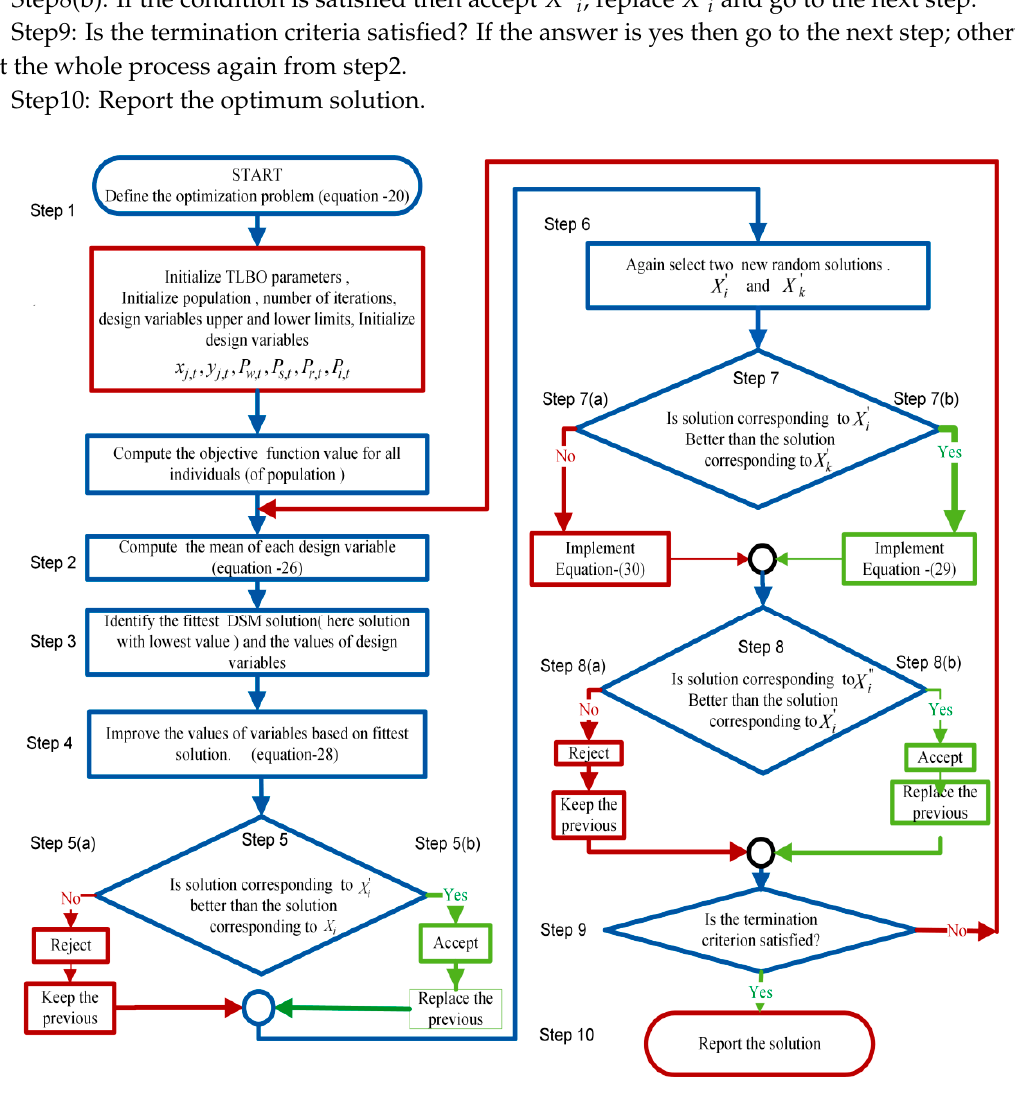
Figure 7. Flow chart of TLBO implementation to optimize F ( X ).